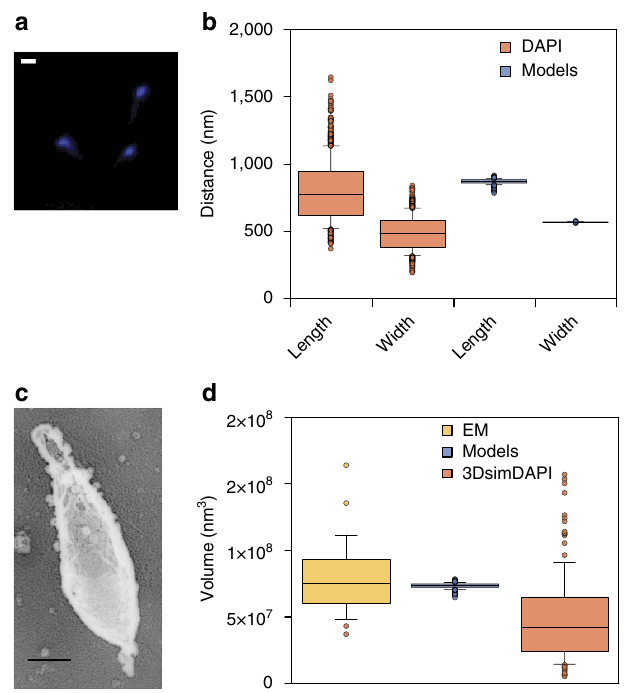
Figure 2 | Validation of chromosome dimensions and occupancy by DAPI staining and EM imaging. ( a ) A DAPI-stained image showing the subcellular localization of DNA in M. pneumoniae . Scale bar, 1 m m. ( b ) Comparison of the estimated lengths and widths of both the DAPI and the estimated chromosome models in nanometre. Boxplot distribution and median values of length (775nm) and width (482nm) over 900 cells, here shown in orange, are estimated from the DAPI images. Boxplot distribution and median values of length (874nm) and width (568nm), estimated over 1,000 chromosome models are shown in blue. ( c ) Quick-freeze deep-etch replica TEM imaging of a M. pneumoniae cell. Scale bar, 200nm. ( d ) Distribution and median volume of a M. pneumoniae cell based on electron microscopy over 25 cells (0.075 m m 3 ; in yellow), on an estimation over 1,000 chromosome models (0.074 m m 3 ; in blue), and on DAPI-based three-dimensional super-resolution microscopy over 130 cells (0.042 m m 3 ; in orange).